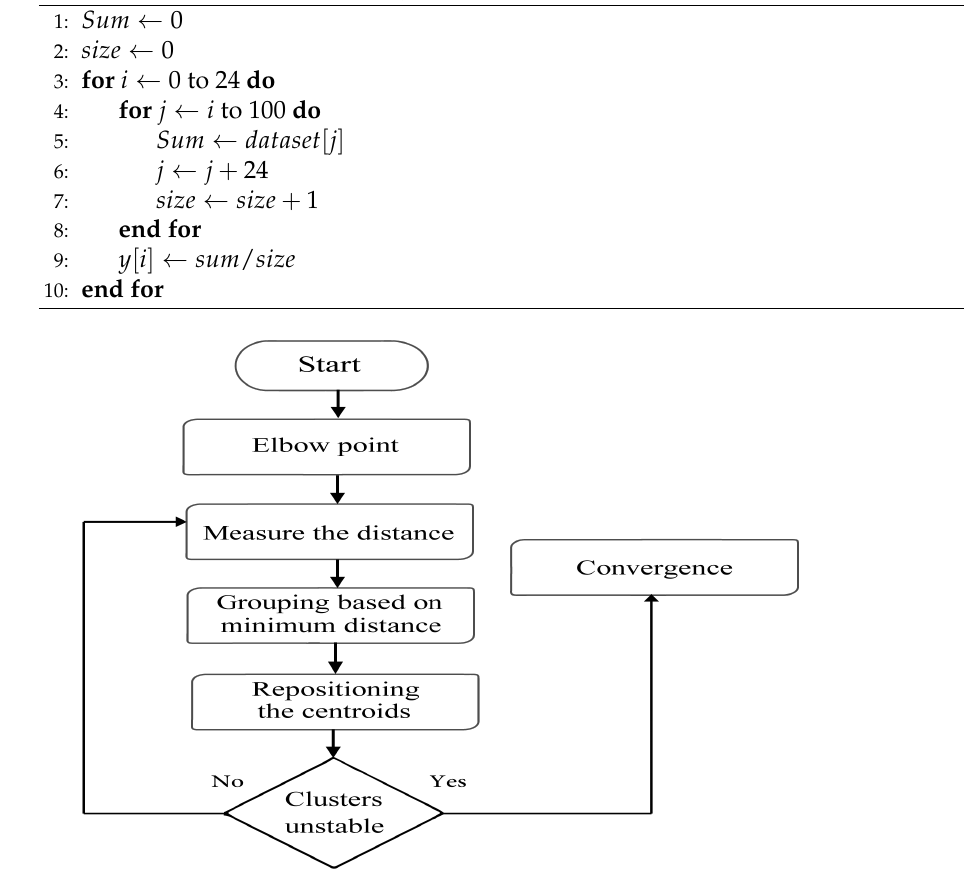
Algorithm 1 Hourly mean average electricity consumption for one trading round